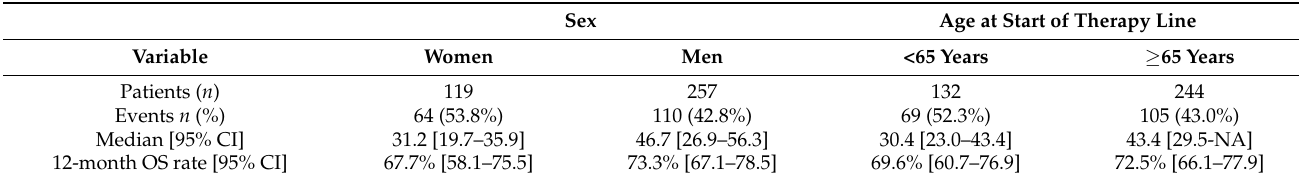
Table 2. Sensitivity analyses for OS of FAS-cohort I on subgroup sex and age.